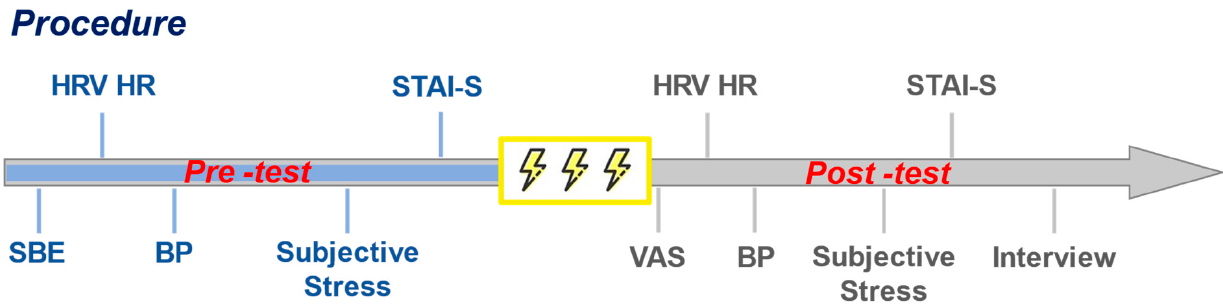
Figure 2. The measurements and testing procedure.